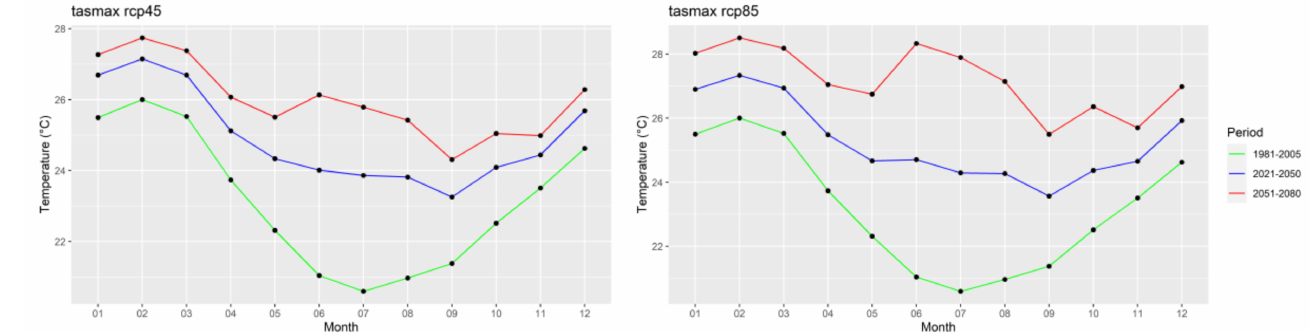
Figure 24. Average monthly temperature (minimum) under RCP4.5 and RCP8.5 scenarios for the Devil’s Creek, 2021–2050 and 2051–2080 periods. The multi-model ensemble average of 15 GCMs.